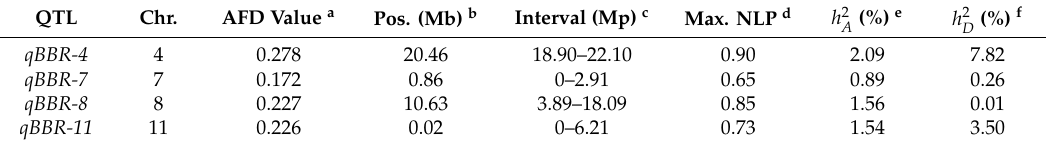
Figure 3. Estimates of confidence intervals of the four QTLs, qBBR-4 ( A ), qBBR-7 ( B ), qBBR-8 ( C ), and qBBR-11 ( D ). The horizontal orange dashed lines indicate the threshold (0.165) at the overall significance level of p < 0.05. The light green areas indicate 95% confidence intervals of the QTLs. Previously reported R genes or QTLs within or closely near the confidence intervals of qBBR-4 , qBBR-8 , and qBBR-11 are indicated on the right. AFD: allele frequency difference. Table 2. Estimates of position and heritability of the four identified QTLs.